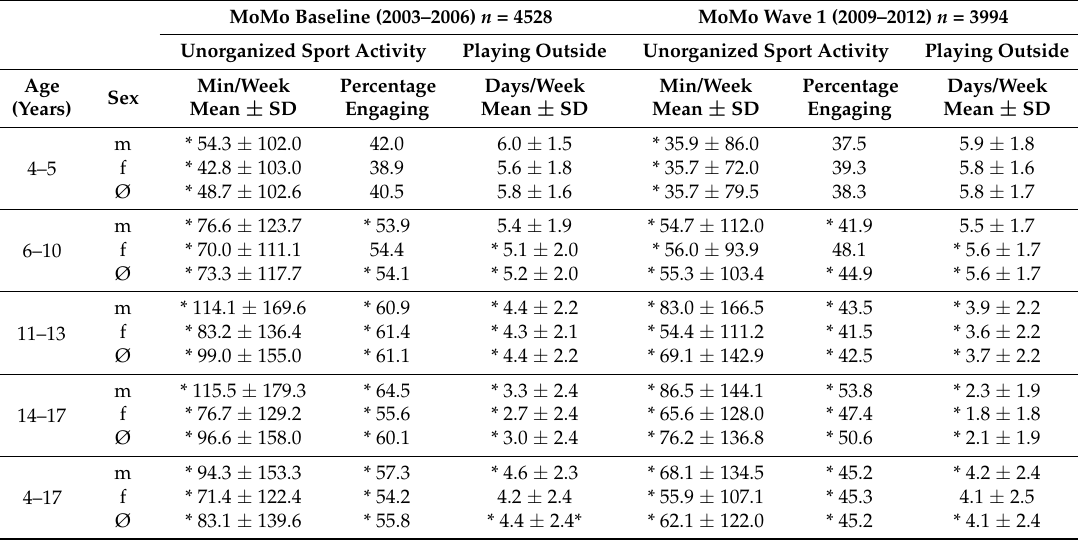
Table 3. Unorganized sport activity of German children and